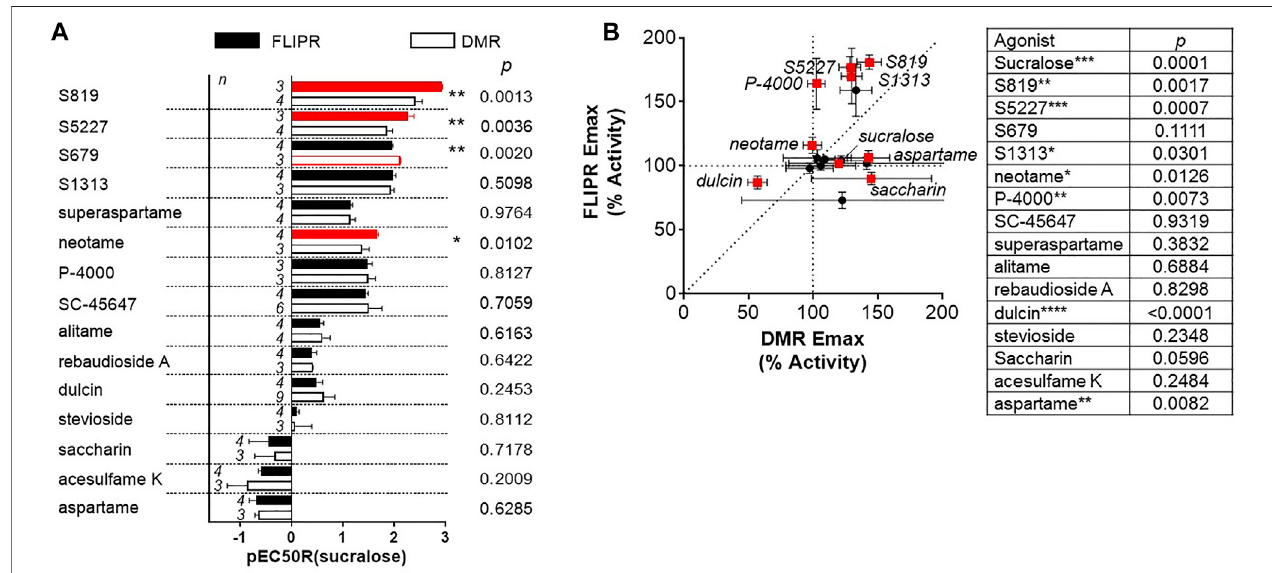
FIGURE 6 | Potency and ef fi cacy bias analysis. (A) Agonist potency values (pEC50s) obtained in each assay were normalized to that of sucralose as described in Materials and Methods . Each pair of the resulting values (pEC50R(sucralose)) were then analyzed by an unpaired, t -test ( α = .05). (B) Agonist ef fi cacy (Emax) values obtained ineach assaywereand summarizedin Table1 wereplottedagainst each other. Each pair ofEmaxvalueswereanalyzedbyanunpaired, t -test ( α =.05) (*** p < 0.001, ** p < .01, * p < .05).